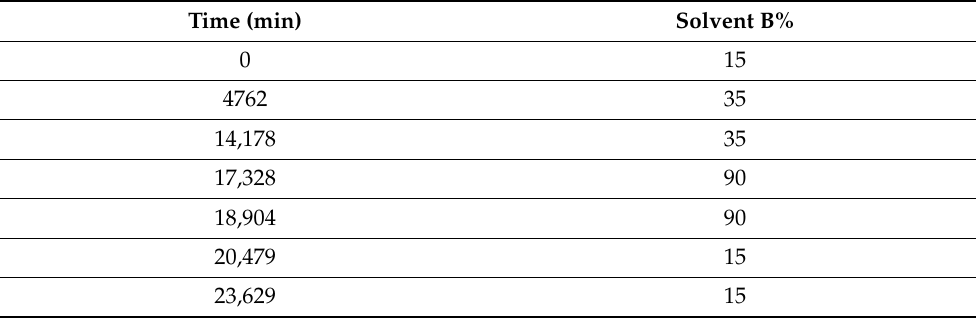
Table 1. Gradient elution profile of H 2 S measurement with monobromobimane using 0.1% TFA/H 2 O (Solvent A) and 0.1% TFA/ACN (Solvent